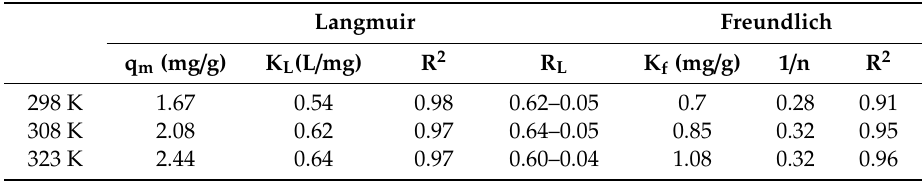
Table 5. Constant parameters for Langmuir and Freundlich adsorption isotherm model. Langmuir